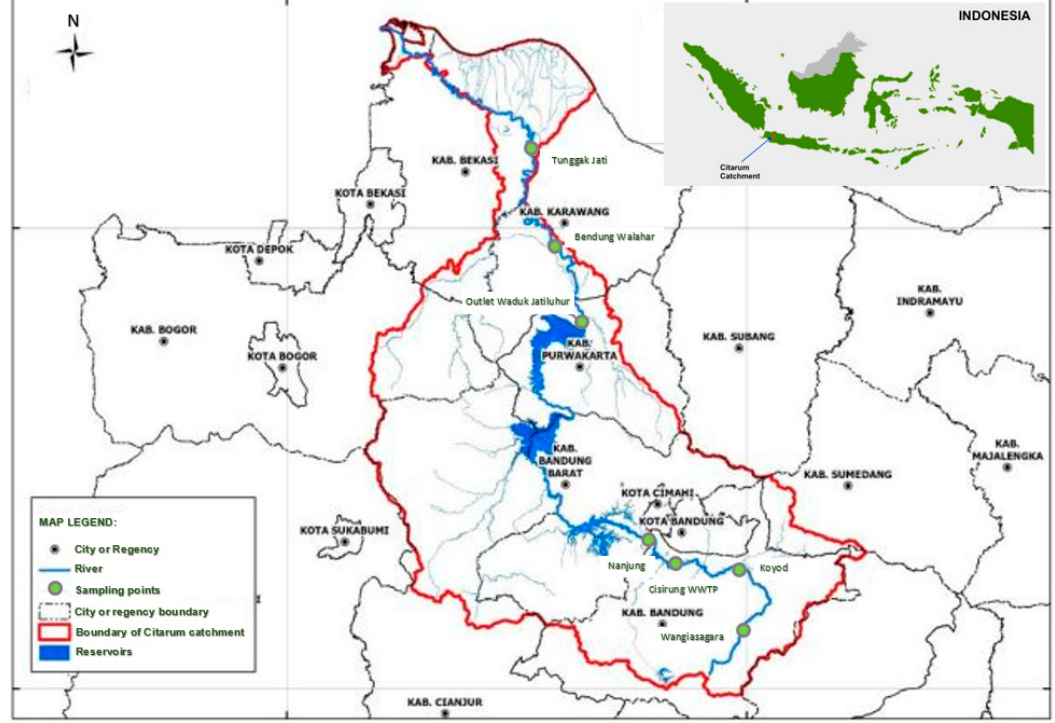
Figure 1. Citarum River monitoring locations, adapted from [24].